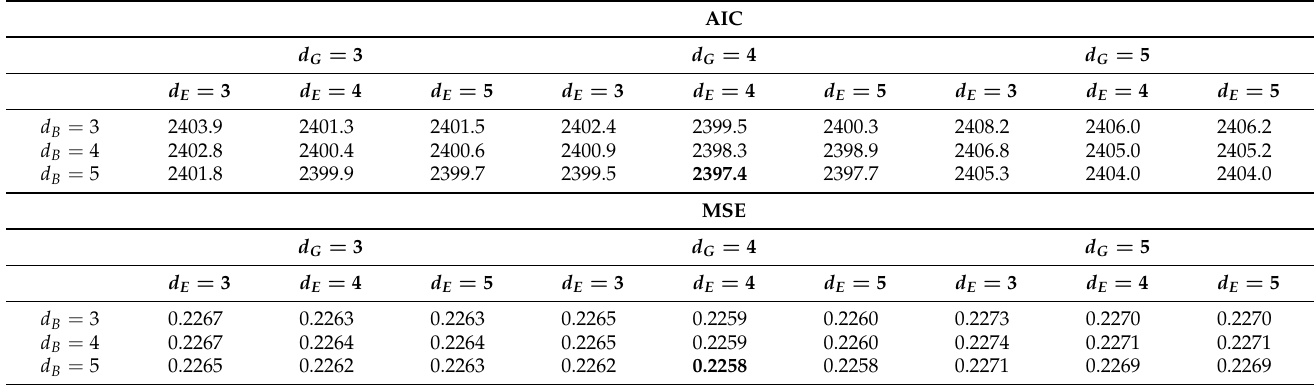
Figure 4. Values of AIC (top panel) and MSE (bottom panel) against different weight matrices W (horizontal axis) for d 0 = 3,4,5,6 and p = 10,11,12,13. Table 3. AIC and MSE values for different combinations of d G , d E and d B (periods of delay for G , E and B , respectively) within d 0 ± 1. Lowest values of AIC and MSE are indicated by